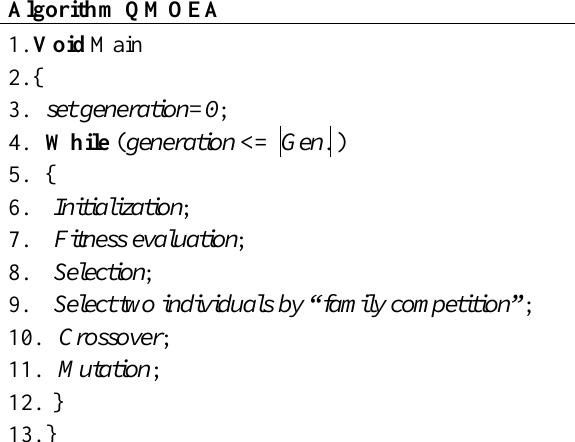
Fig. 6 Pseudo-code for